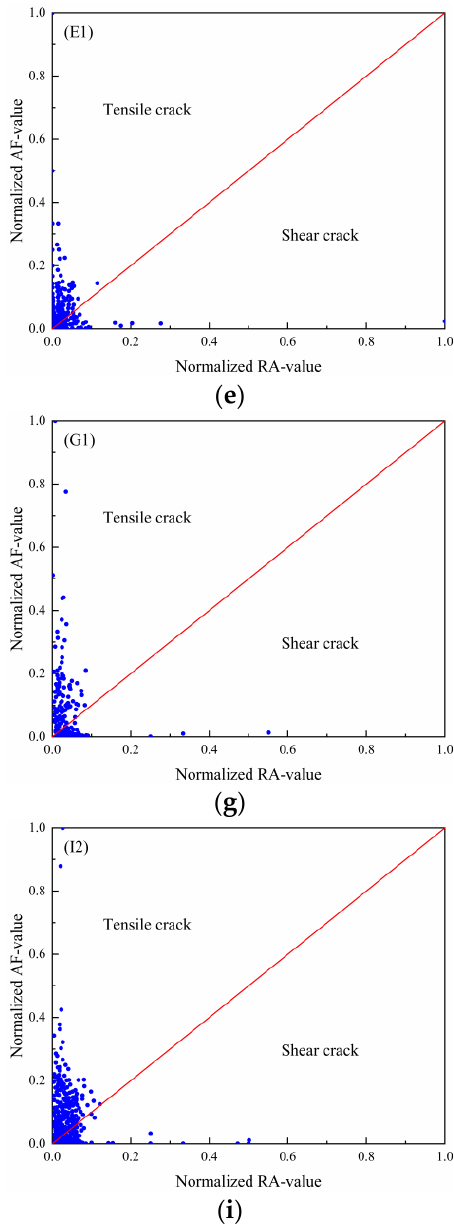
Figure 10. RA – AF distribution of tuff specimens with different moisture content. ( a – i ) Specimens under different moisture content.